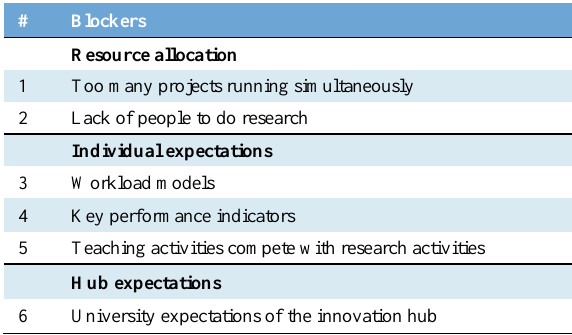
Table 2. Research process and production blockers.